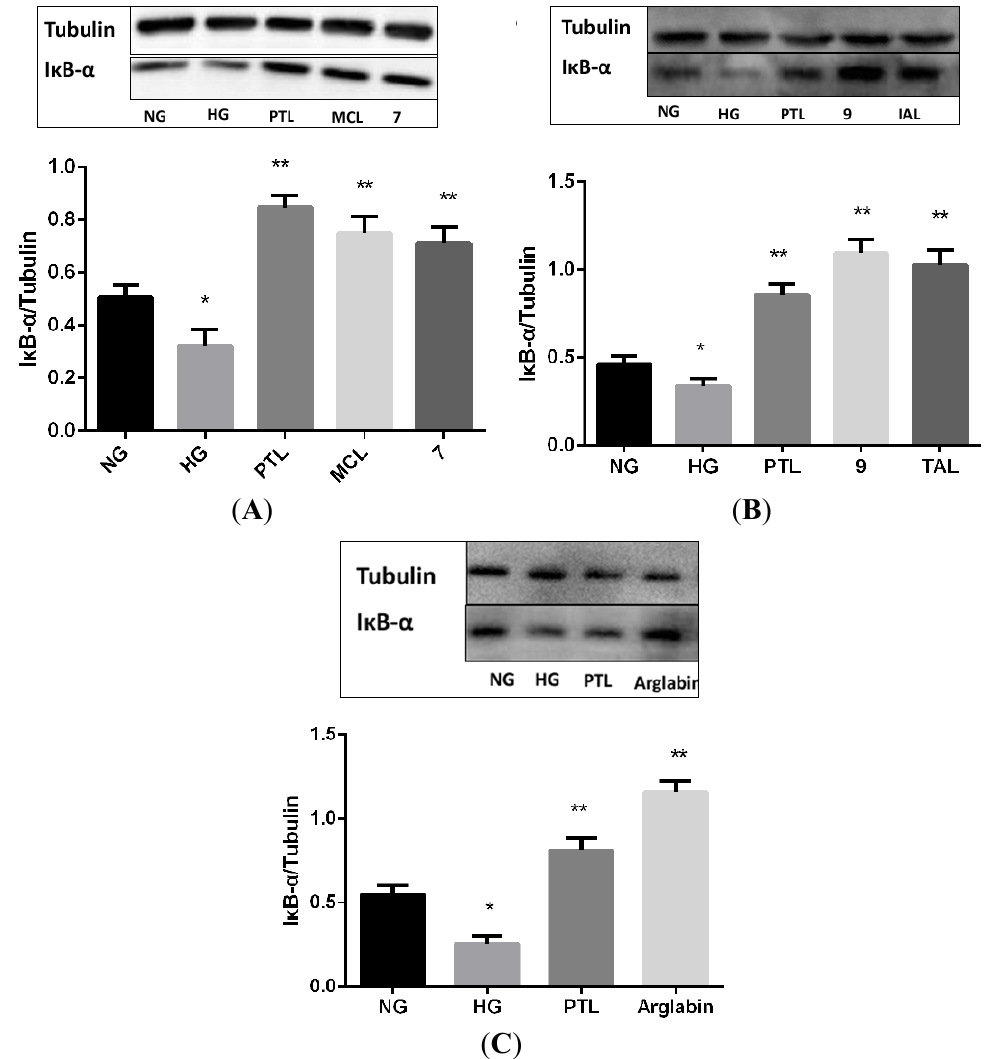
Figure 5. Effect of sesquiterpene lactones on HG-induced regulation of I κ B α protein